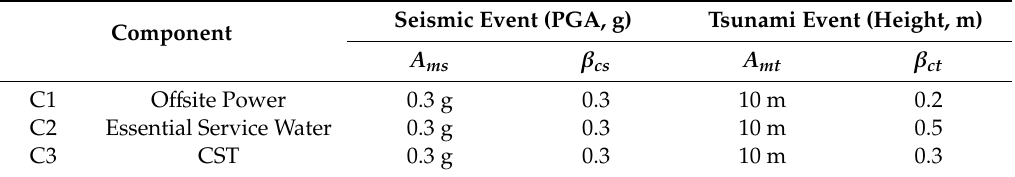
Table 1. Fragility information of components for an earthquake and a tsunami external hazard